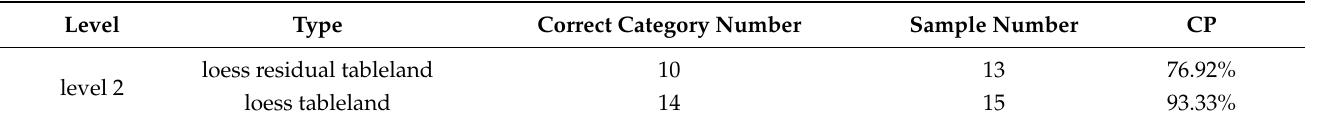
Table 5. Statistical results of the second level precision rate of tableland and residual tableland area.